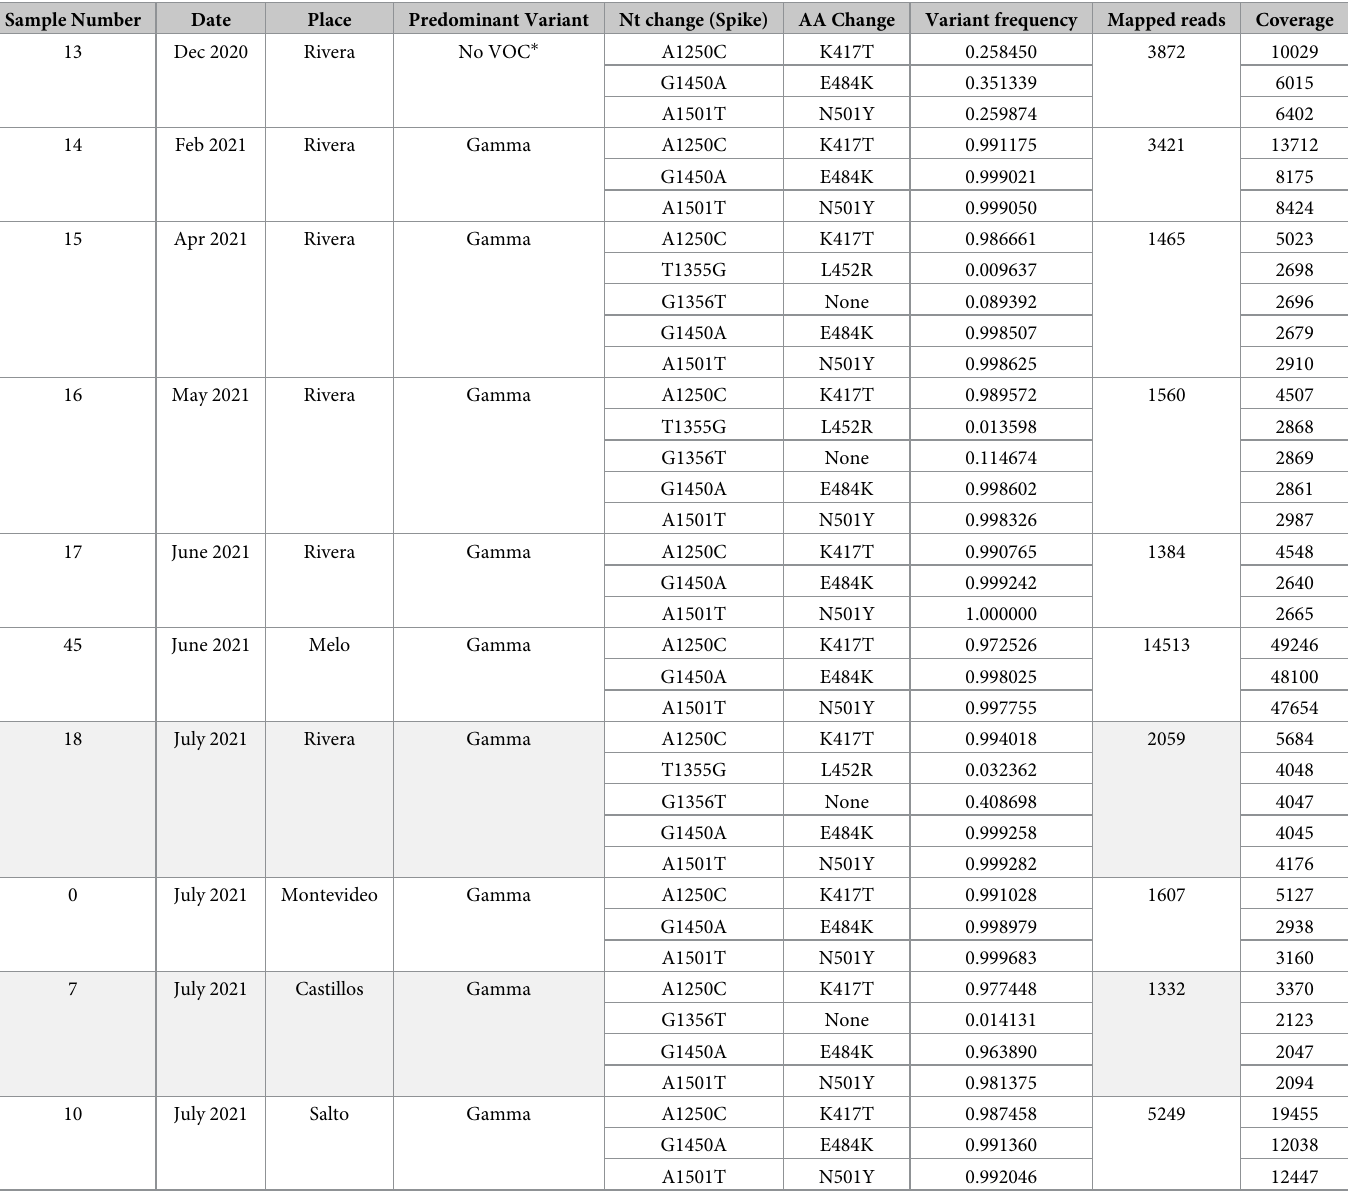
Table 2. Analysis done using the SAMRefiner